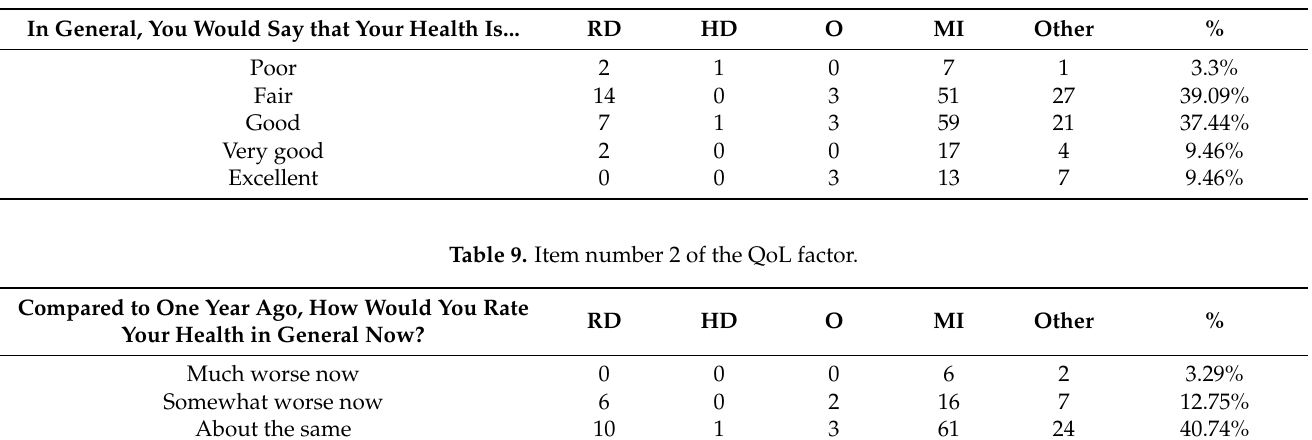
Table 8. Item number 1 of the QoL factor.